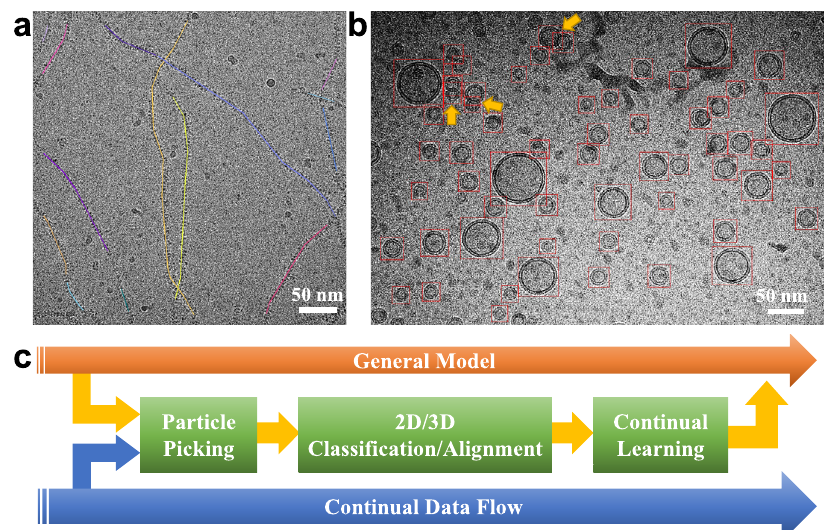
Fig. 5 Picking of general biological objects and a work fl ow with continual learning. a Picking curved fi bers. The picked fi bers are labeled as lines tracing the fi bers. b Picking liposomes with estimation of radius (indicated by size of the red box). Several overlapped vesicles (indicated by yellow arrows) are well identi fi ed. c A cryoEM processing work fl ow with continual learning. Particle annotations can be obtained from manual picking, sparse picking, and 2D/3D (two-dimensional/three dimensional) classi fi cation, which can be further used to train the model in a continual